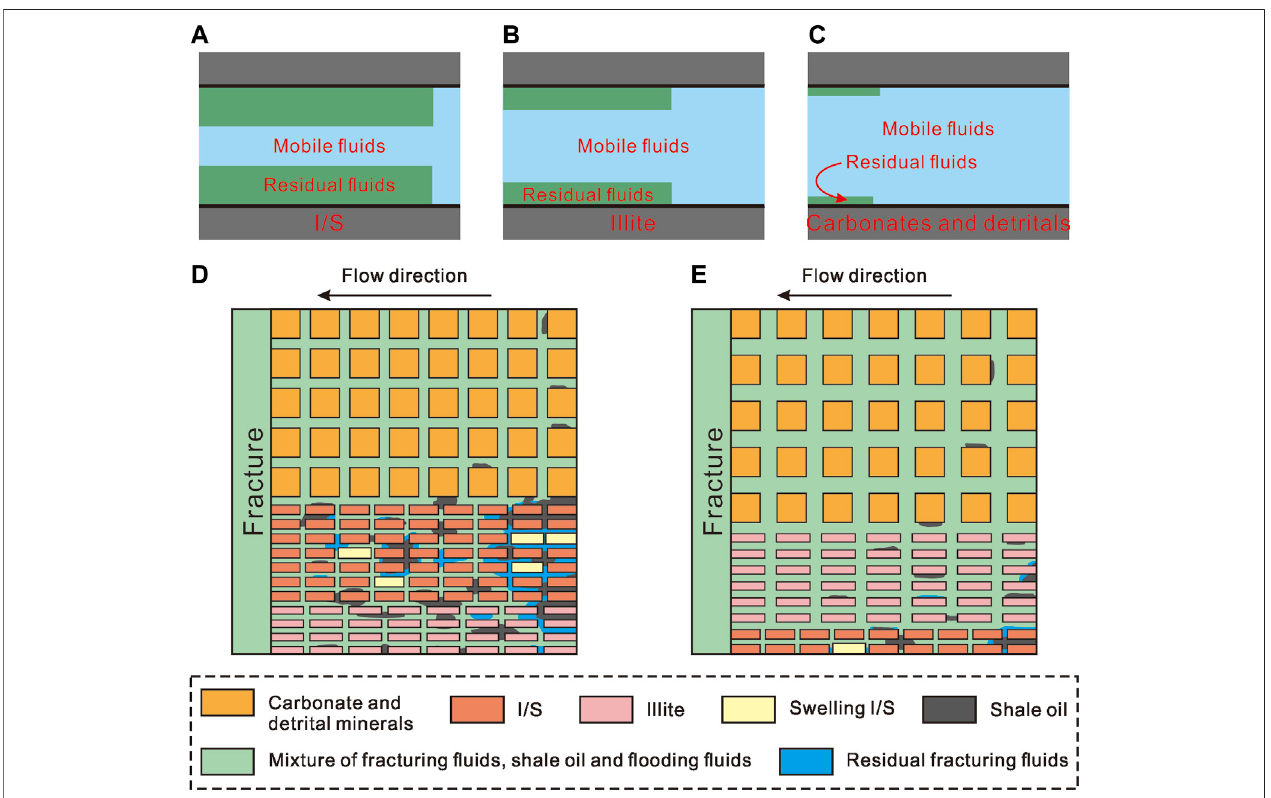
FIGURE 10 | Hypothetical model to explain the effects of characteristics and properties of pores and surfaces on the fl uid fl ow from shale formation to fractures. (A – C) Distribution of mobile and residual fl uids in the pores with different surface properties. (D) Distribution of fl uids after fl ow from shale formation to fractures for the shales from Es 3middle and Es 3lower . (E) Distribution of fl uids after fl ow from shale formation to fractures for the shales from Es 4upper .